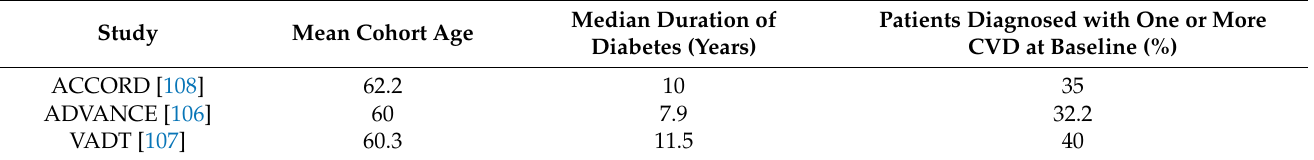
Table 3. Population demographics of patient cohorts in the ACCORD, ADVANCE, and VADT